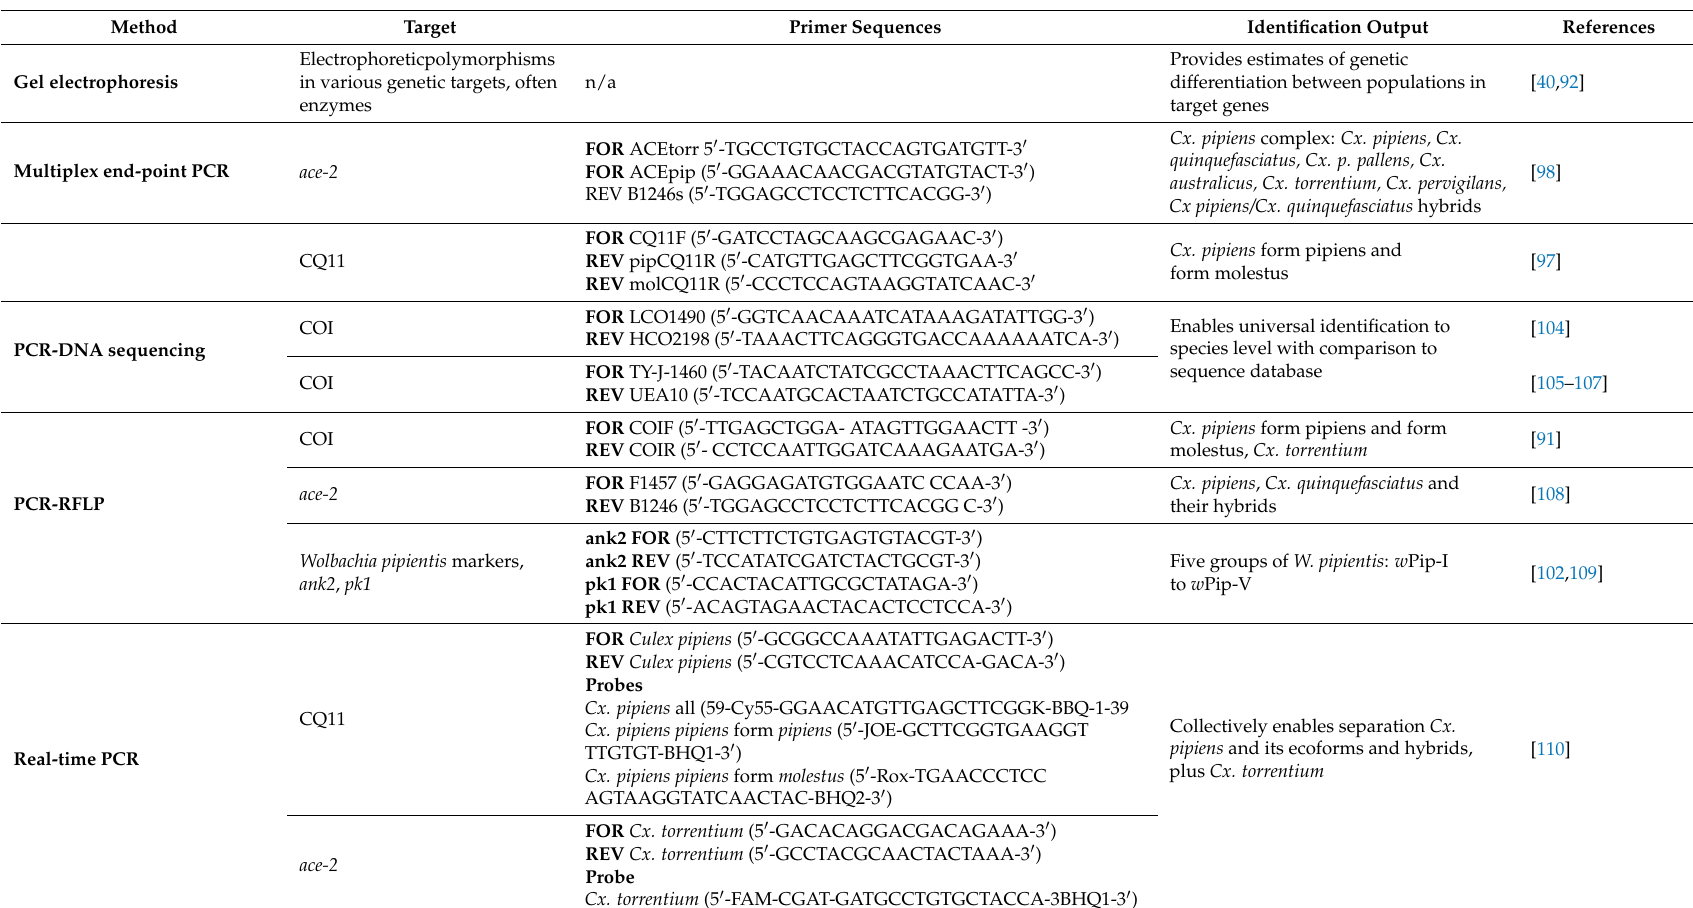
Table 3. Common methods used for the species delineation of the Culex pipiens